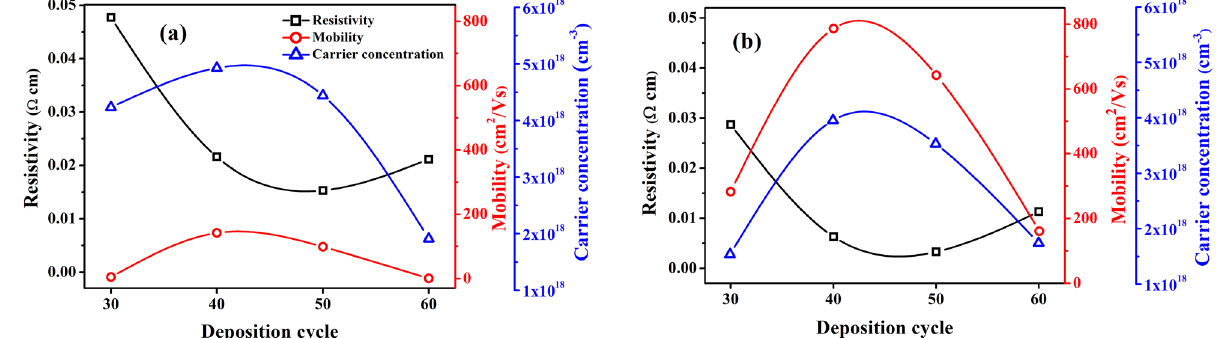
Figure 10. Hall mobility, Resistivity and electron carrier concentration of ZnO films synthesized using ( a ) DW and ( b ) ethanol solvents.